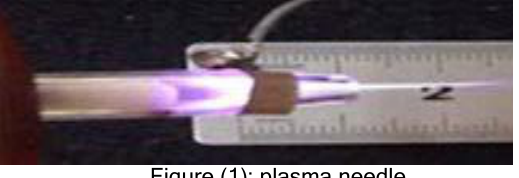
Methods: Hundred patients (100) complaining from different clinical signs and symptoms were admitted to Ramadi Teaching Hospital for seeking medical